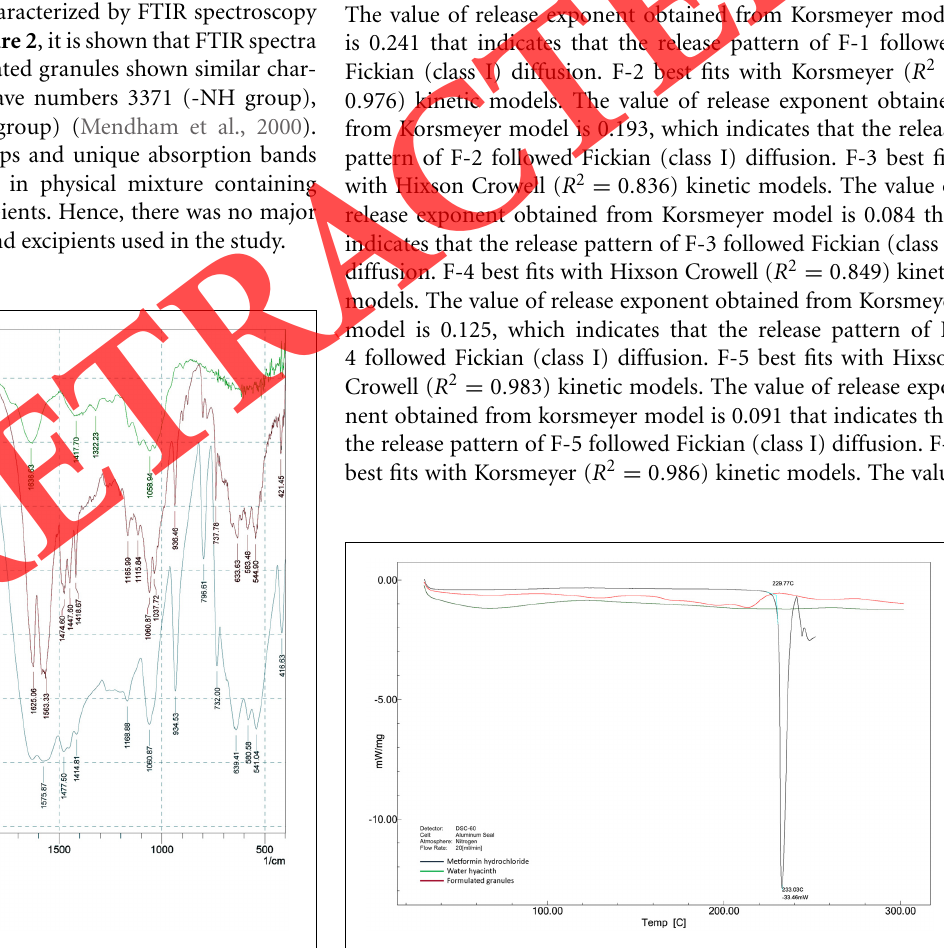
FIGURE 2 | FTIR spectra of Metformin HCl, Water hyacinth, and Formulated granules.